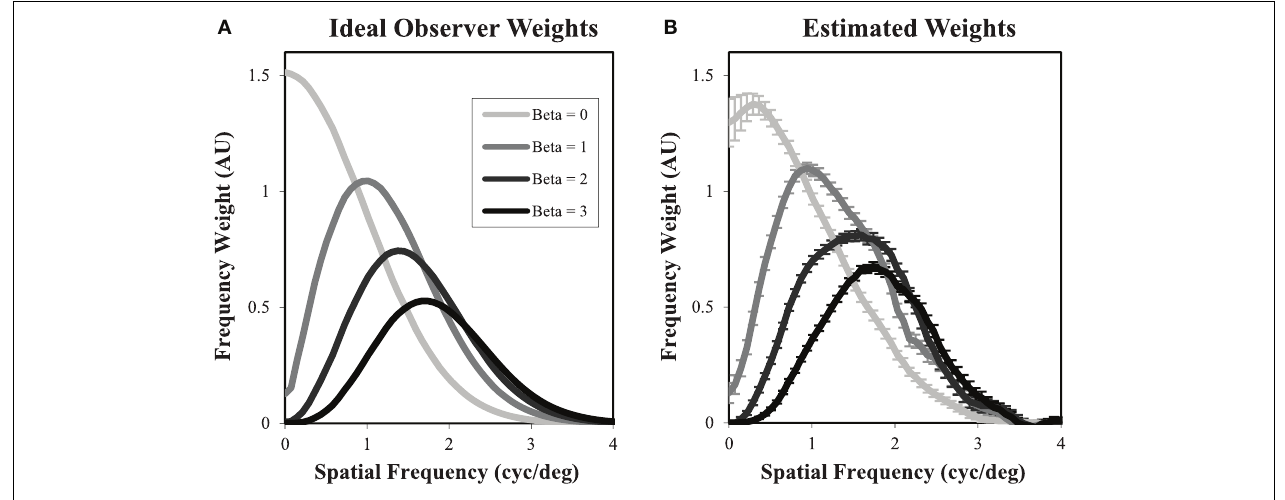
FIGURE 5 | Classification images in free-localization tasks. Ideal observer filter weights (A) were used to generate responses for each power-law exponent. The filter weights were then estimated from the incorrectly